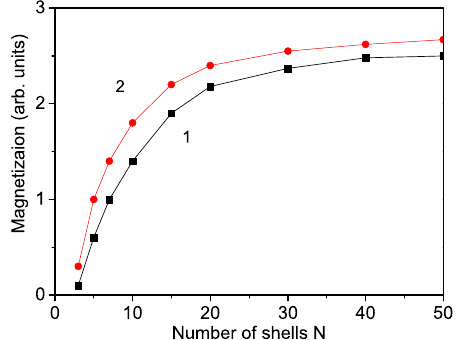
Figure 2. (Color online) The magnetization M s as a function of size and shape in a YFO nanoparticle for T = 300 K, J s = 0.8 J b , h = 100 Oe. (1) Spherical and (2) cylindrical.